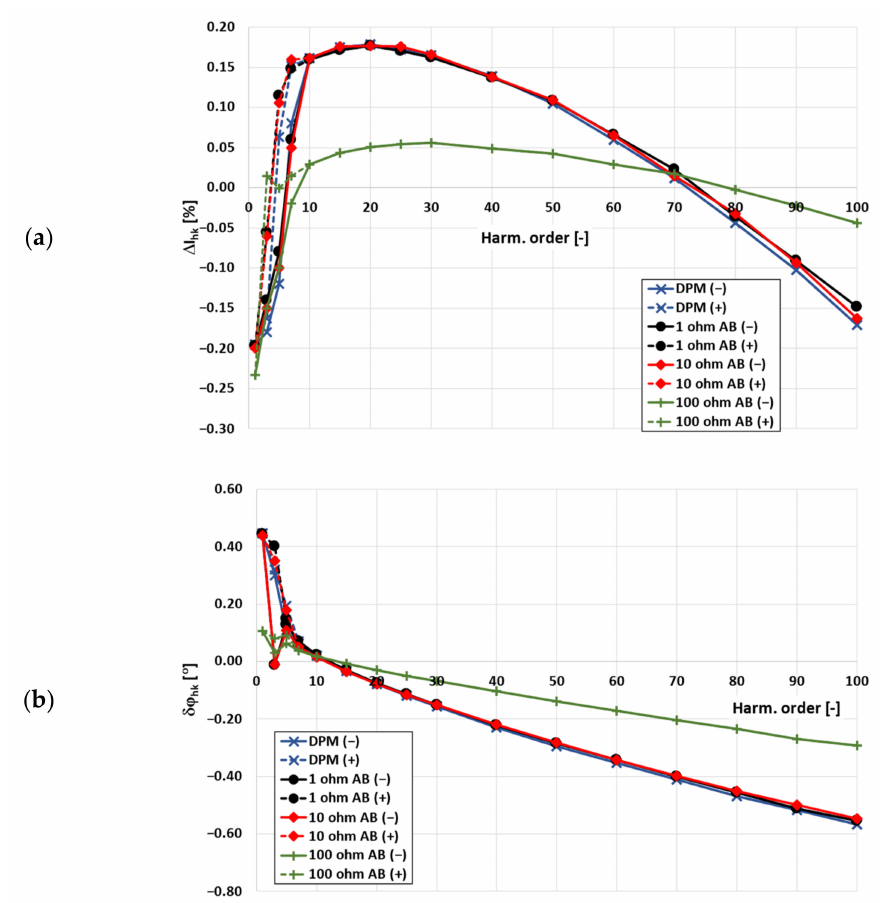
Figure 7. The influence of the self-generated low-order higher harmonics in the 50 Hz-type CT and current shunt resistance on current error ( a ), phase displacement ( b ) for 20% of rated primary current and rated load resistance (used notations are as in Figure